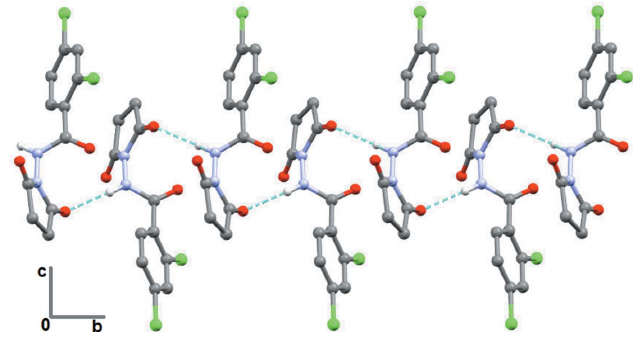
Fig. 2). The crystal structure also features (cid:2) – (cid:2) interactions (Fig. 3): Cg 1 (cid:3) (cid:3) (cid:3) Cg 2 i = 3.9338 (3) A˚ , interplanar spacing = 3.587 A˚ and centroid shift = 1.57 A˚ and Cg 2 (cid:3) (cid:3) (cid:3) Cg 2 ii = 3.9334 (3) A˚ , interplanar spacing = 3.533 A ˚ and centroid shift